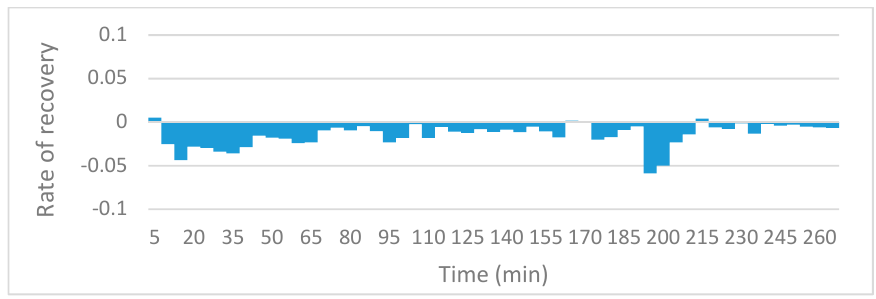
Figure 12. The slope function method to reveal the trend in local resistivity during the 0.5 wt% SiO 2 run no.1.